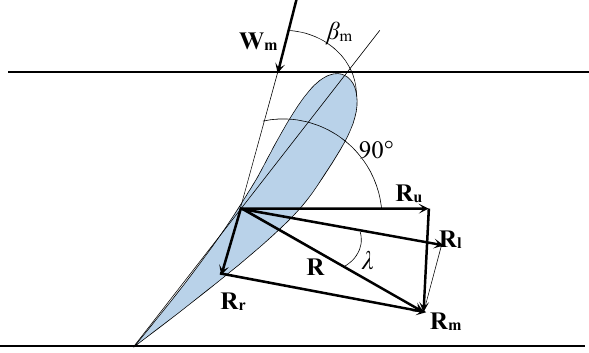
Figure 3. The force analysis for a single blade.